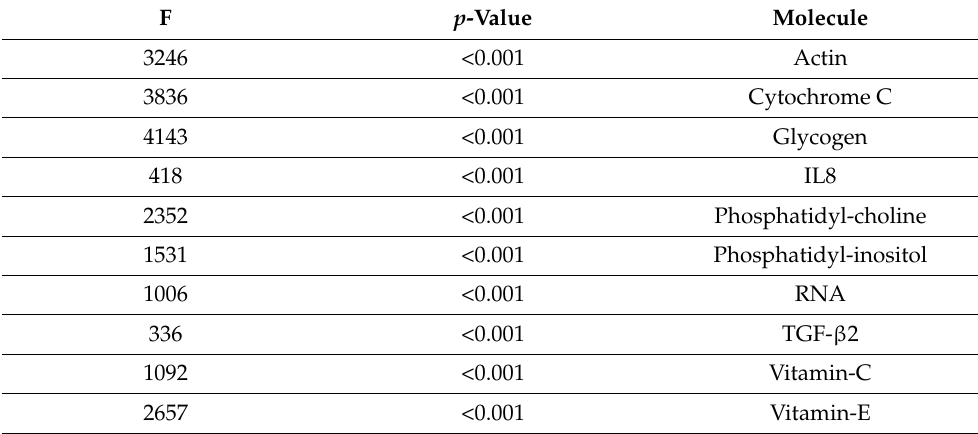
Table 1. Results of testing via Welch’s ANOVA on CLS coefficients from fitting of PNT1A cell spectra. F